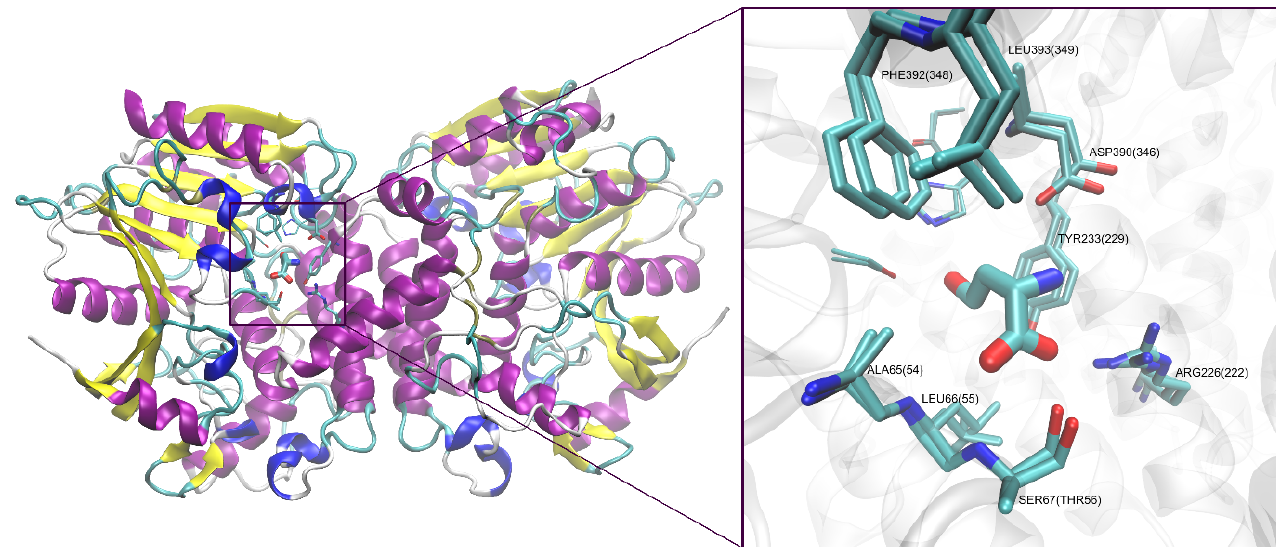
Figure 3. Structure of C. albicans L-homoserine O-acetyltransferase dimer based on the AlphaFold model and the template structure of the enzyme from M. smegmatis (PDBID: 6IOH). To visualize similarity of both binding sites and to obtain the proper ligand orientation for reference and docking results validation, both structures were superimposed with natural substrate of the enzyme (L-HOM), found in the 6IOH pdb file, with neighboring binding site residues are drawn as sticks. Residues are labeled according to the C. albicans sequence numbering. Values in parentheses resemble the numbering of M. smegmatis enzyme. Catalytic triad comprising of Ser 154 (Ser 151 ), His 389 (His 344 ), and Asp 360 (Asp 314 ) is visible in the background, and is depicted with the thinnest sticks, without labels, to keep picture clarity.